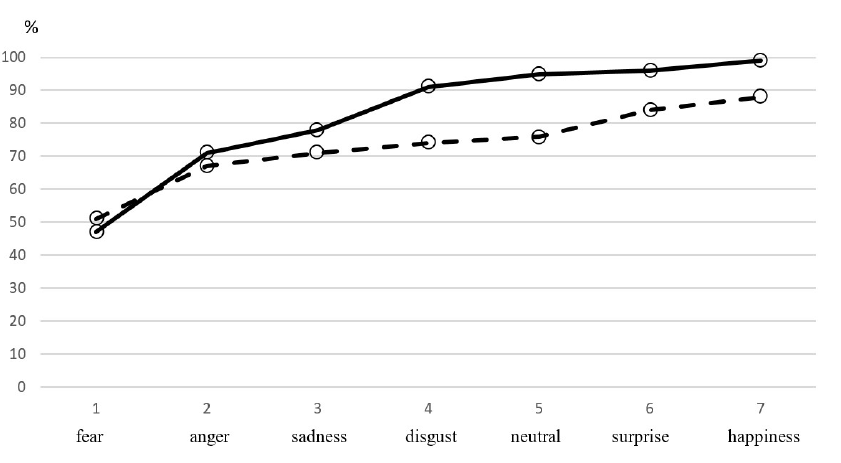
Figure 4. Accuracy of expression recognition in real (continuous line) and synthesized (dotted line)